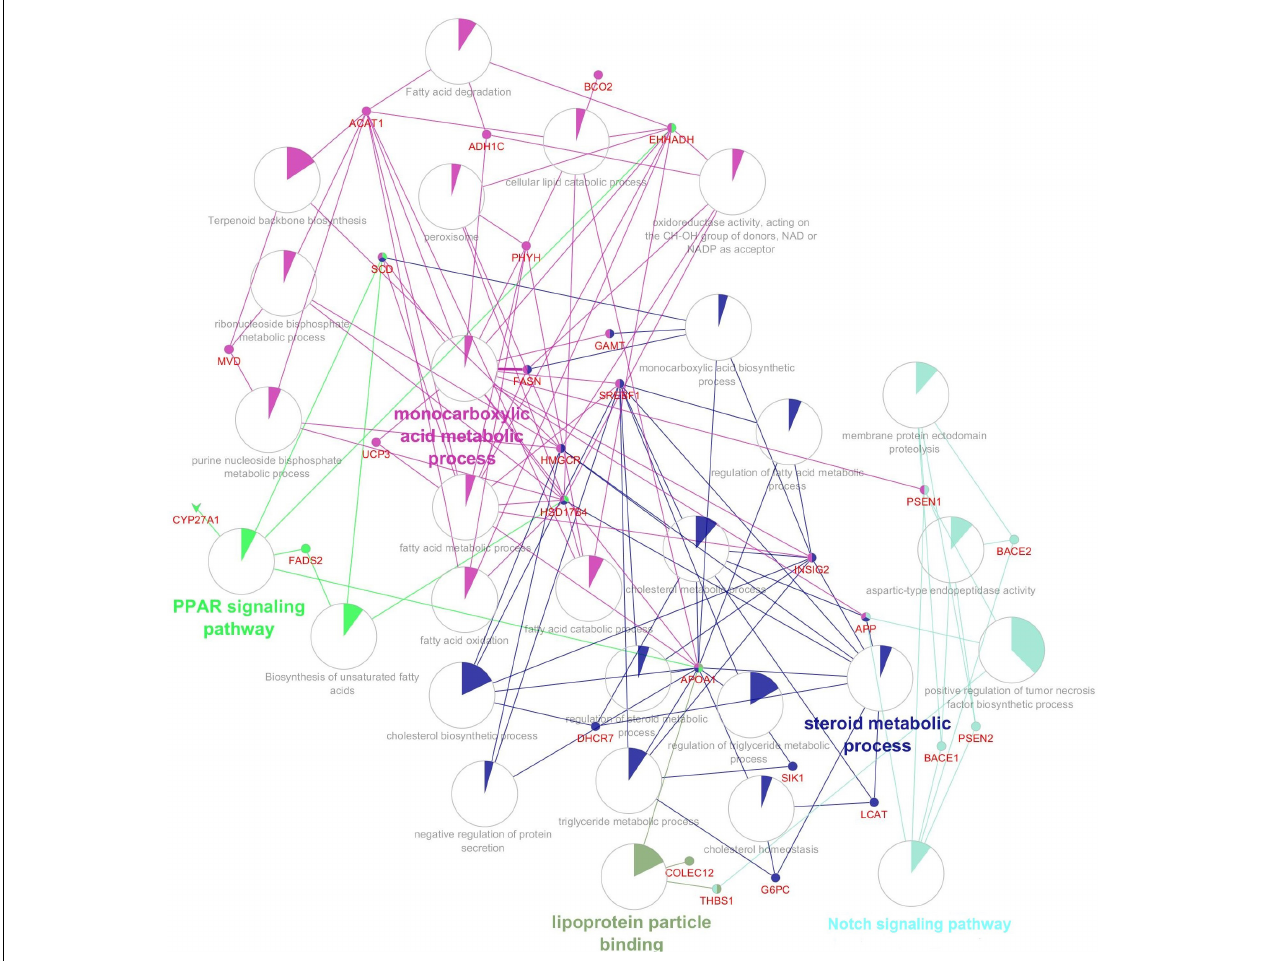
FIGURE 2 | The gene, gene ontology and pathway, and related interaction network involved in the abdominal fat storage of the